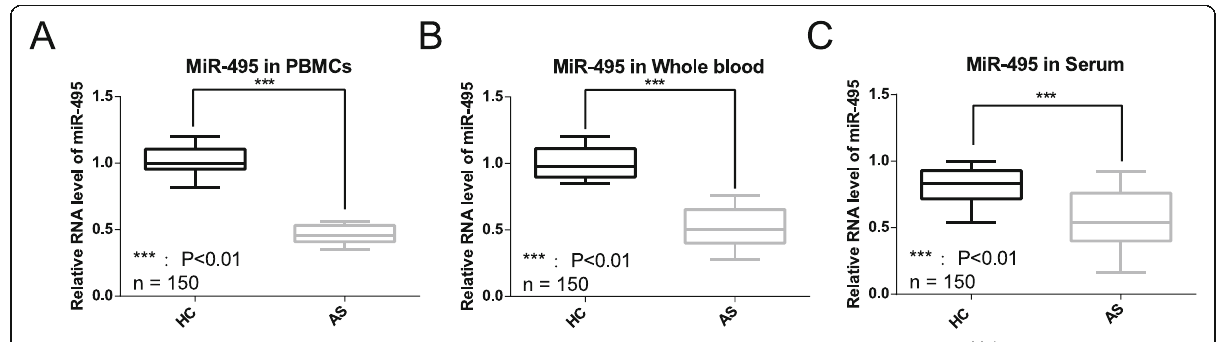
Fig. 1 Detection of miR-495 expression. The expression levels were presented as the mean + SD and calculated by 2 - △△ ct . a Expression of PBMC miR-495 . miR-495 expression in healthy controls and patients with AS is 1.02 + 0.11 and 0.464 + 0.071, respectively. b Expression of whole blood miR-495 . miR-495 expression in healthy controls and patients with AS is 0.993 + 0.116 and 0.523 + 0.158, respectively. c Expression of serum miR- 495 . miR-495 expression in healthy controls and patients with AS is 0.813 + 0.147 and 0.36 + 0.162, respectively. AS: patients with ankylosing spondylitis. HC: healthy controls. n = 150: tested samples in each group. ***: P value <